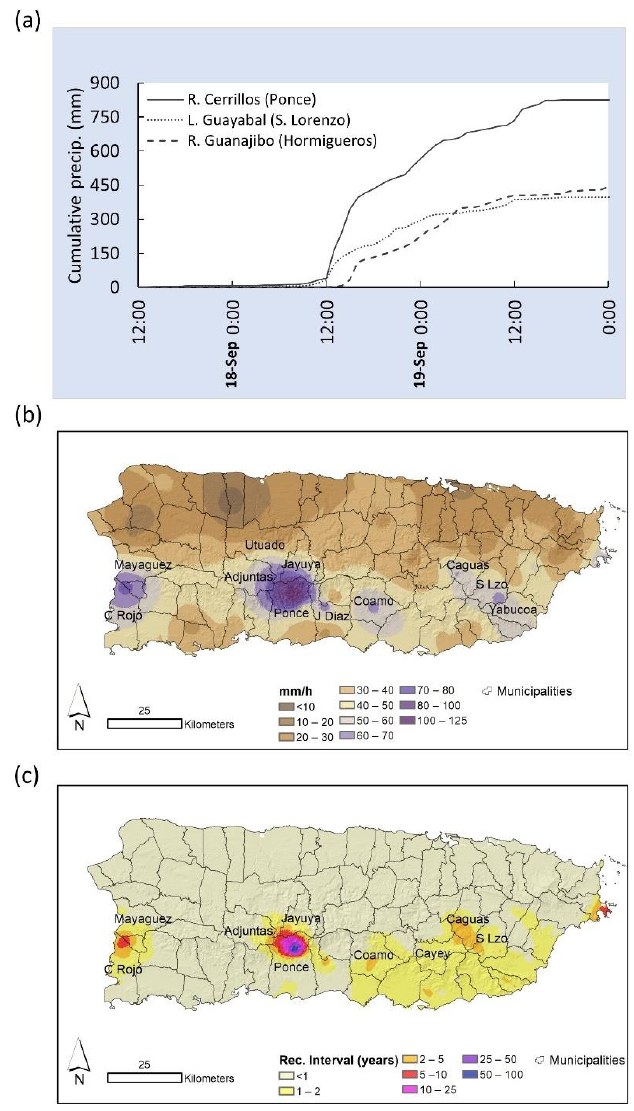
Figure 3. Hurricane Fiona’s 1 h P int characteristics. ( a ) Hour-by-hour cumulative rainfall totals for three stations at different locations in the eastern (Lago Guayabal), central (Río Cerrillos), and western (Río Guanajibo) portions of Puerto Rico; ( b ) Spatial distribution of 1 h P int in mm h −1 during Hurricane Fiona based on cokriging analyses of data collected from 77 recording weather stations; ( c ) Spatial distribution of 1 h P int recurrence intervals for Hurricane Fiona. The maximum 24 h P int values recorded at a station during HF were 21.8 mm h −1 at the Río Cerrillos station in Ponce and 22.4 mm h −1 at the La Plaza station in Caguas (USGS 50999961). The geometric mean of all 24 h P int observations was 10.4 mm h −1 . The island- wide mean 24 h P int based on interpolations was 9.79 mm h −1 , which places HF as the fourth-ranked TC in PR since 1899 behind Hurricanes María (12.7 mm h −1 ), San Ciriaco (11.3 mm h −1 ), and Georges (10.6 mm h −1 ), respectively [28] (Figure 4). Maximum daily intensities exceeding 12.5 mm h −1 occurred over 24% of the island between the municipal- ities of Ponce and Orocovis in the central region, from Coamo and Santa Isabel to Yabucoa on the south, between Juncos and the Rio Grande in the northeast, and in Lares in the west. Maximum 24 h P int values exceeding 17.5 mm h −1 occurred over 3% of the island in